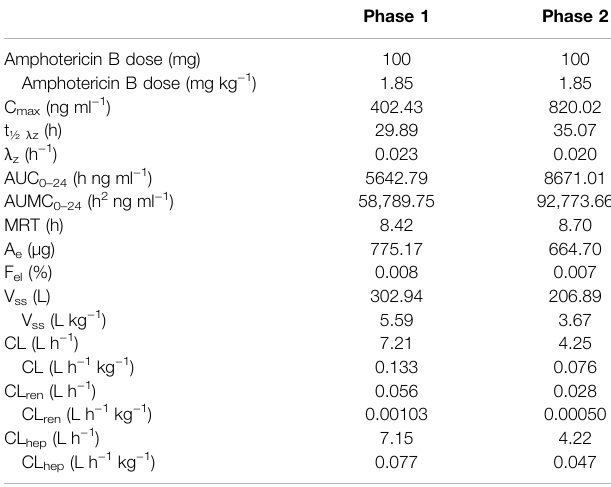
TABLE 5 | Pharmacokinetics parameters of amphotericin B in a patient with neurocryptococcosis at the beginning and at the end of the